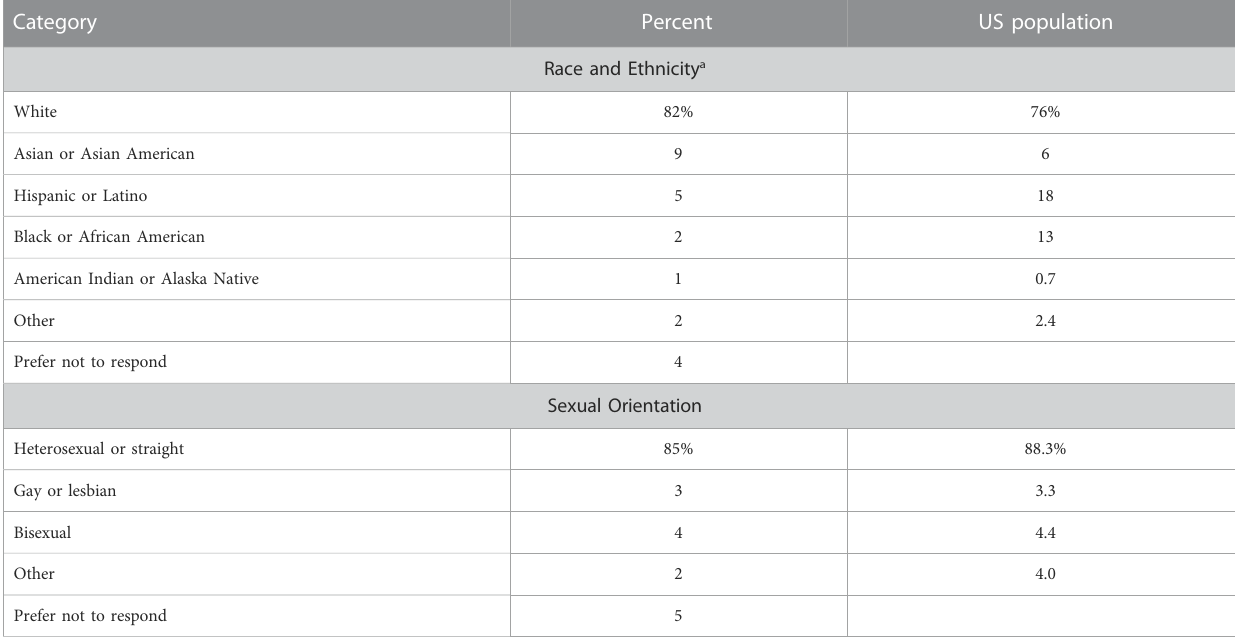
TABLE 2 AAS race/ethnicity and sexual orientation information from the 2018 membership demographics report.